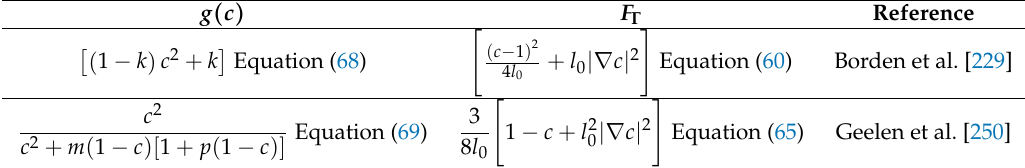
Table 1. Definition variants for the degradation function g ( c ) and the functional F Γ